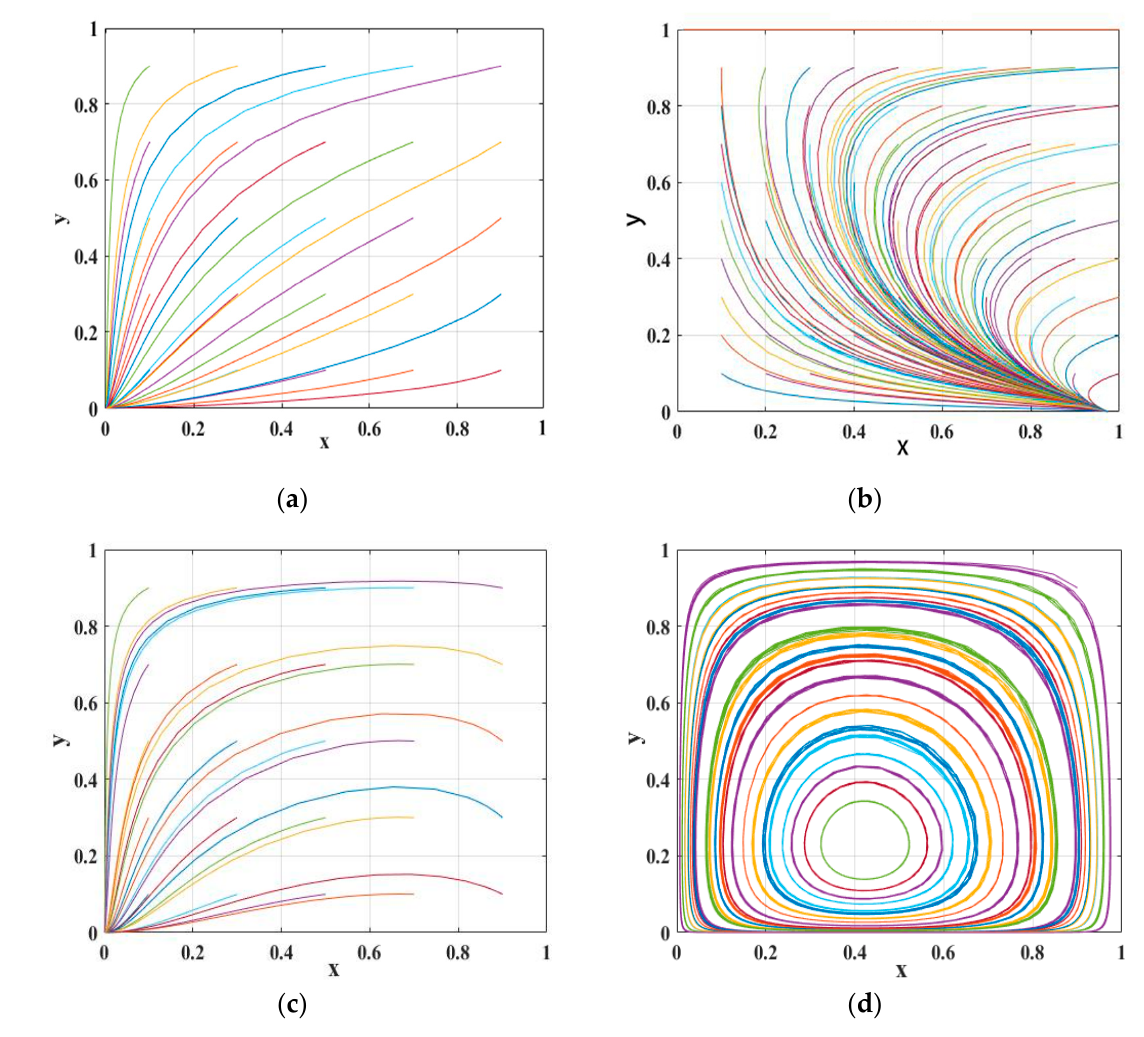
Figure 1. Simulation results of four scenarios. ( a ) Scenario 1; ( b ) Scenario 2; ( c ) Scenario 3; ( d ) Scenario 4.